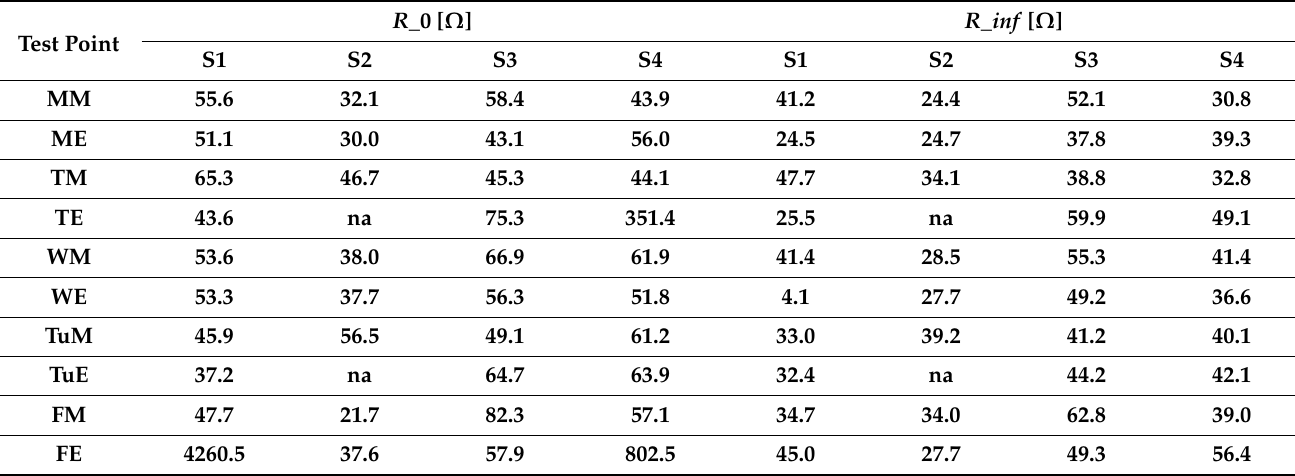
Table 2. Cole–Cole parameter R_0 and R_inf for S1 to